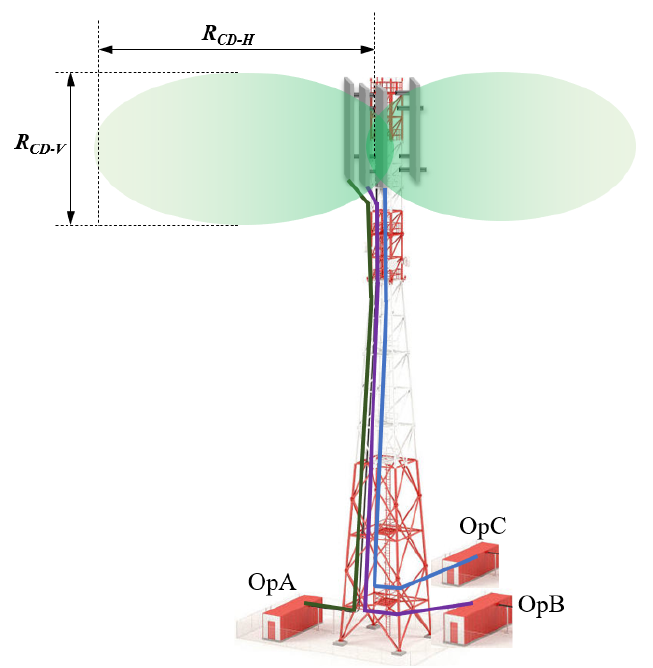
Figure 4. The horizontal R CD-H and vertical R CD-V compliance distances for macro site installed on rooftop tower.